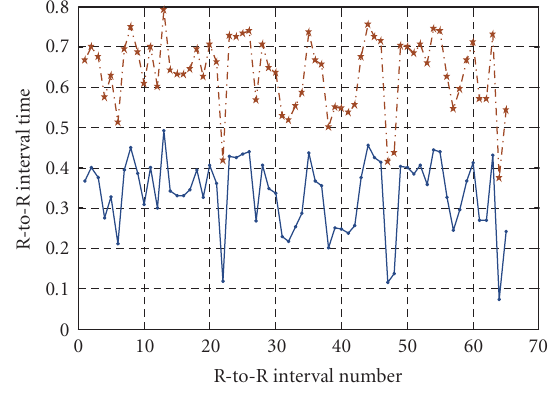
Figure 14: A typical R-R interval before and after removing the baseline wander; top graph represents before removal and the other one is after